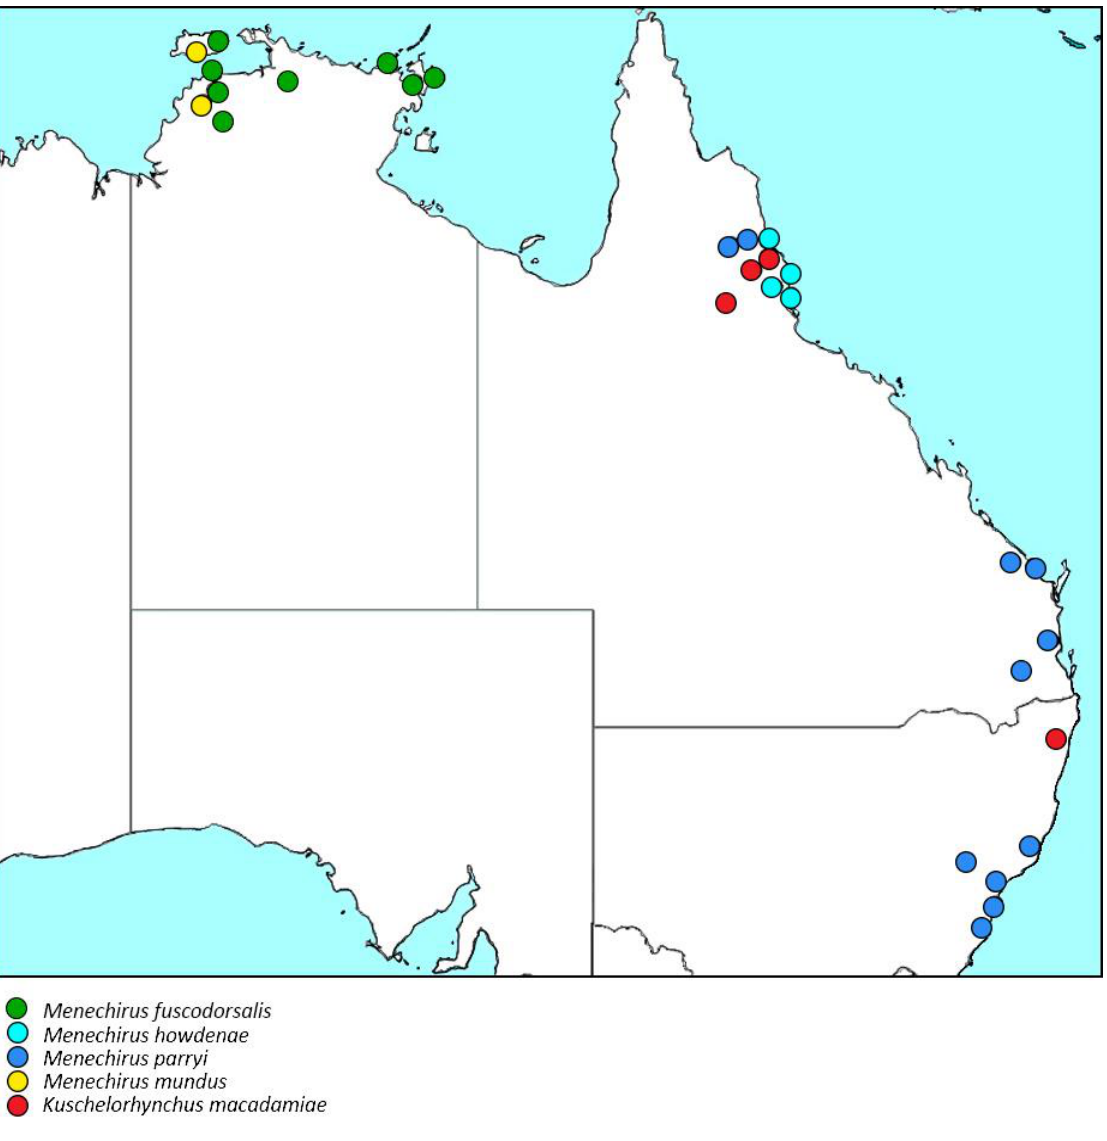
Figure 13. Distribution of the species of Menechirus Hartmann and Kuschelorhynchus gen. n. in Australia.